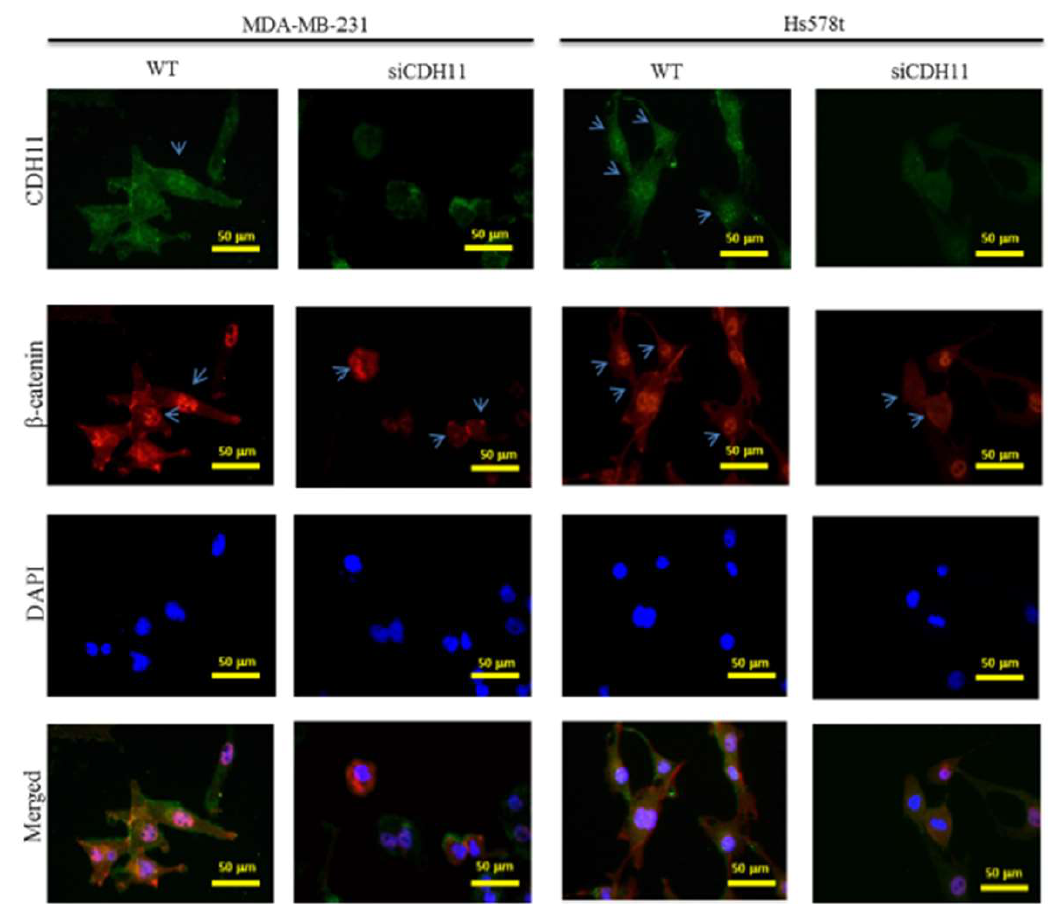
Figure 4. Knockdown of CDH11 using siRNA reduces β -catenin nuclear co-localization in TNBC cells. Immunofluorescence staining of MDA-MB-231 and Hs578t cells with CDH11 (green), β -catenin (red), and DAPI (blue). The results show that silencing CDH11 concurrently reduced CDH11 and β -catenin protein expression level and their nuclear localization. The blue arrows indicate presence and absent of CDH11 and β -catenin in the nuclear region. Images are representative of four separate assays in triplicate. Scale bar: 50 µm.